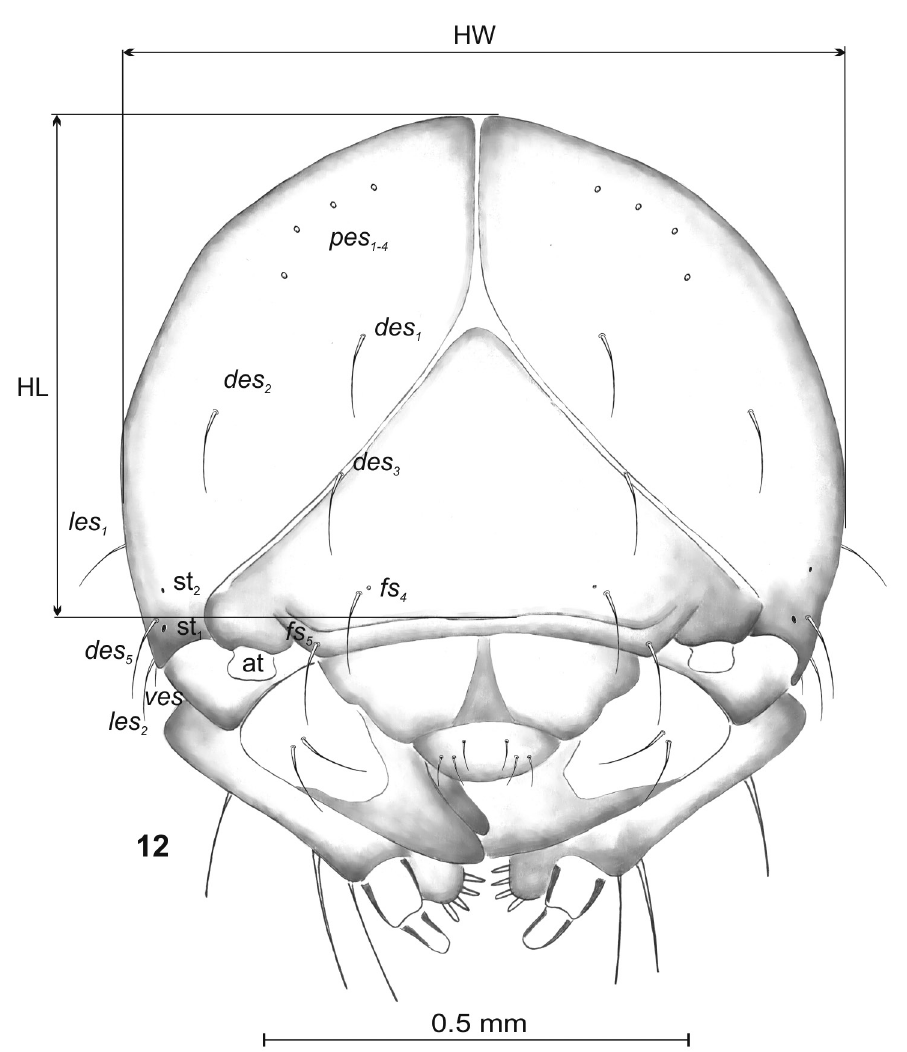
Figure 12. Strophosoma capitatum , mature larva, head. Abbreviations at – antenna, HL – head length, HW – head width, st – stem - mata. Setae: des - dorsal epicranial, fs – frontal, les - lateral epicranial, pes – postepicranial, ves –